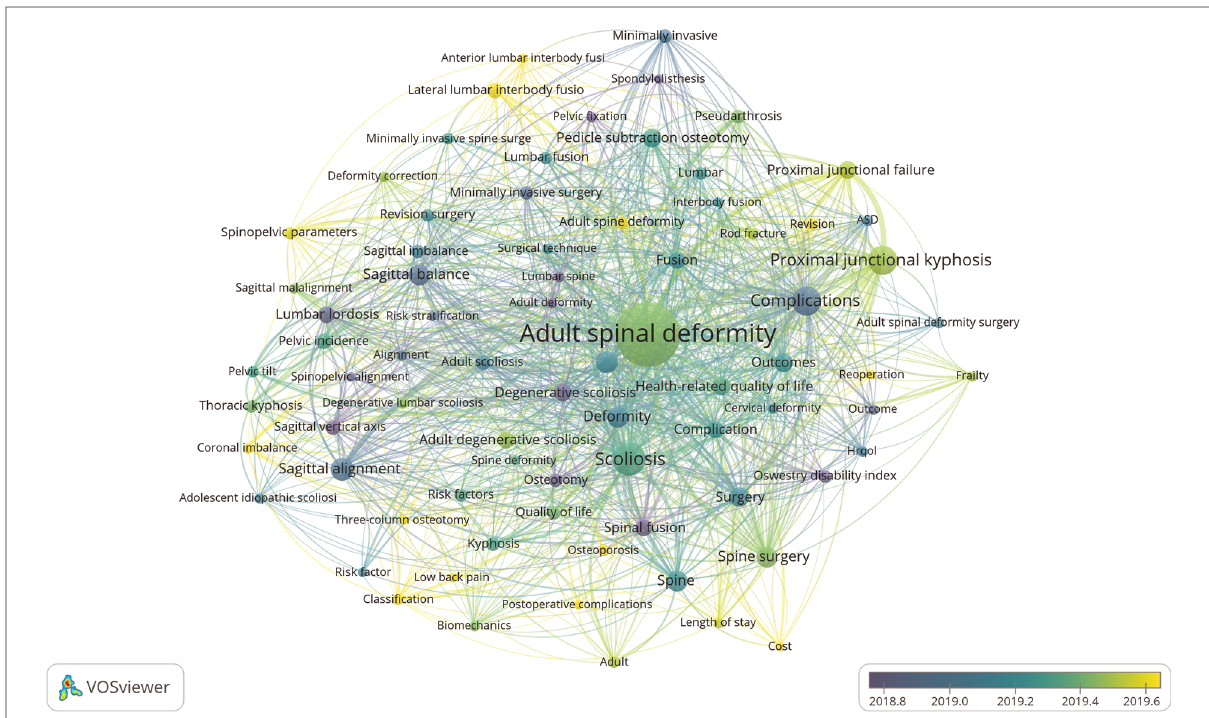
FIGURE 5 The network visualization analysis of author keywords of the whole articles published in the recent 5 years (time-dependent overlay